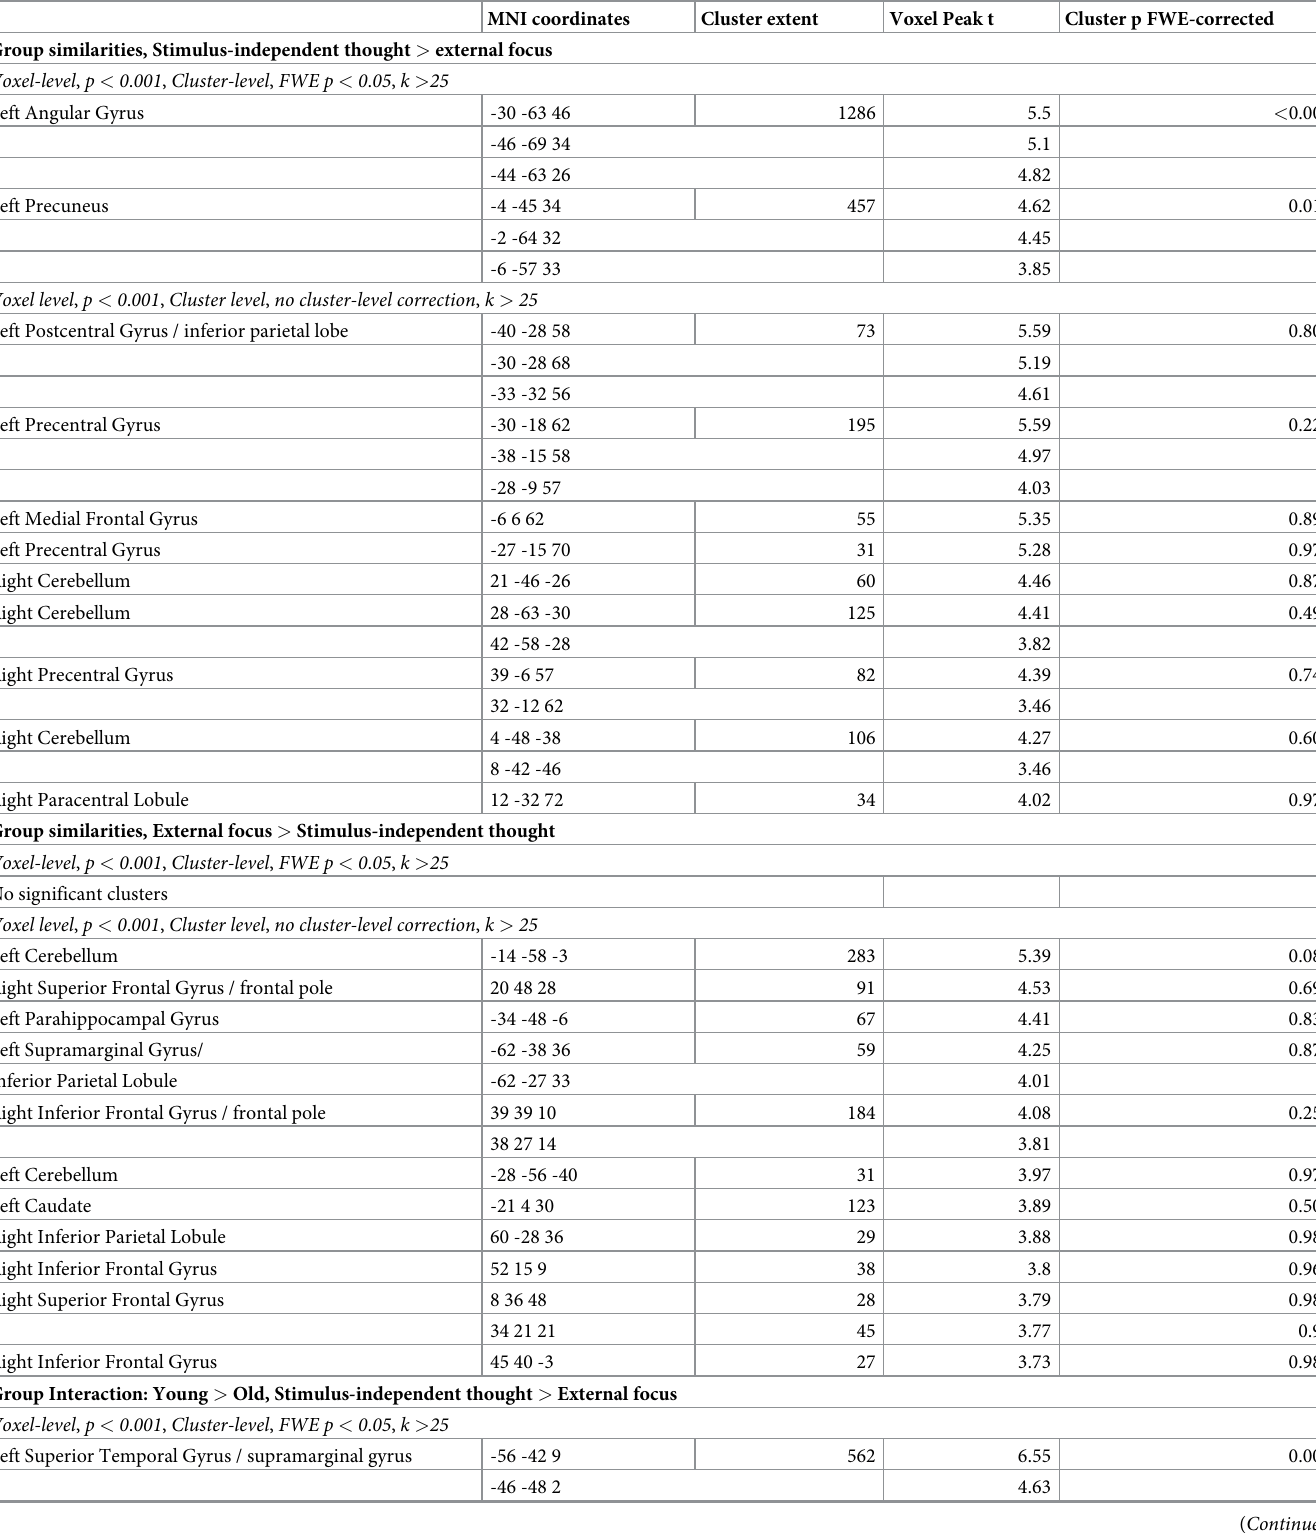
Table 2. fMRI activation results. MNI coordinates Cluster extent Voxel Peak t Cluster p